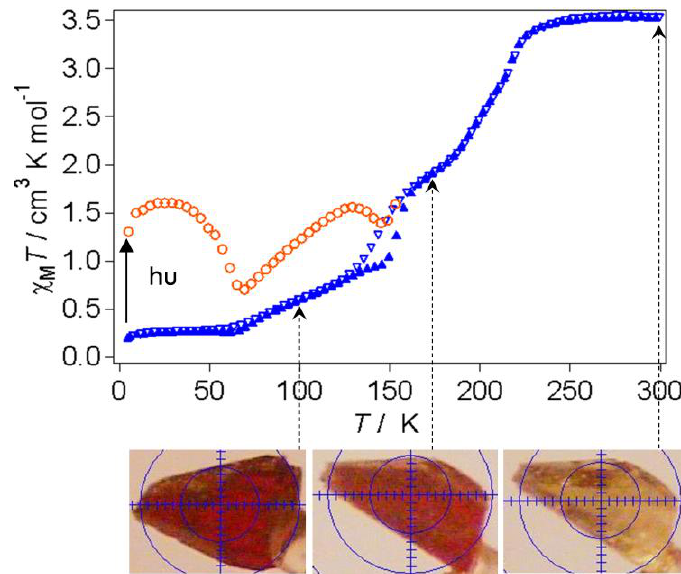
Figure 3. Magnetic susceptibility of the spiral assembly. Solid triangles show the results with increasing temperature, open triangles show the results with decreasing temperature, and open circles show the results alter illumination of